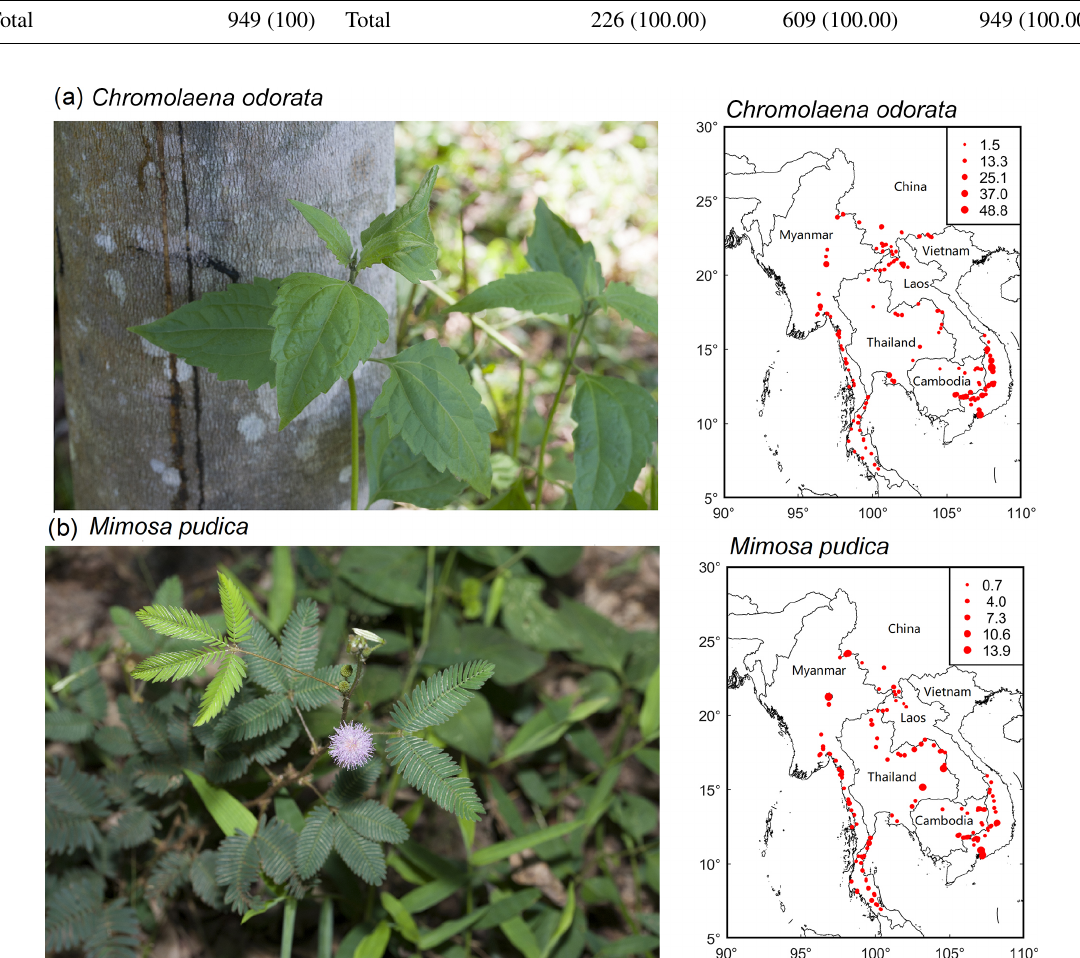
Figure 2. Distribution maps of two common exotic species ( a : Chromolaena odorata ; b : Mimosa pudica ) of rubber plantations in the GMS (circle size is proportional to importance